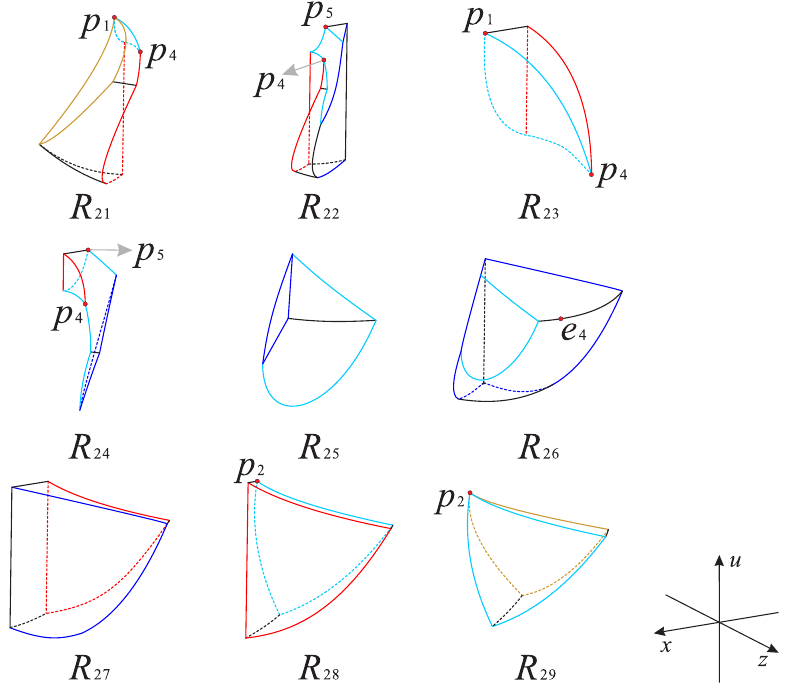
Figure 23. There are the nine subregions inside the region R 2 of the Poincaré